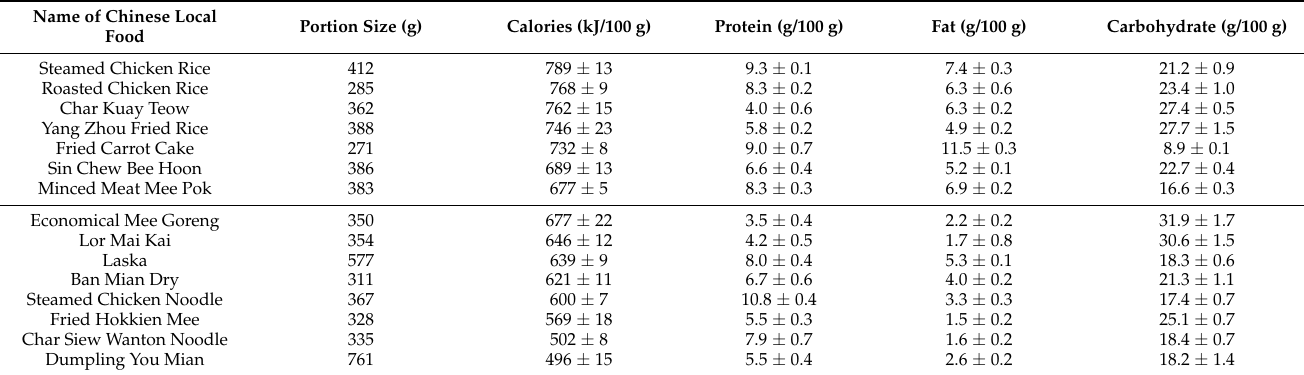
Table 1. Energy and macronutrient content of the commonly consumed Chinese cuisines.